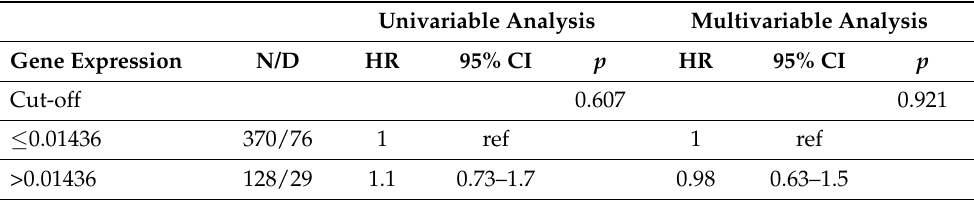
Table 15. Overall Survival of 498 NB patients in relation to LOC339788 expression levels evaluated by the Cox